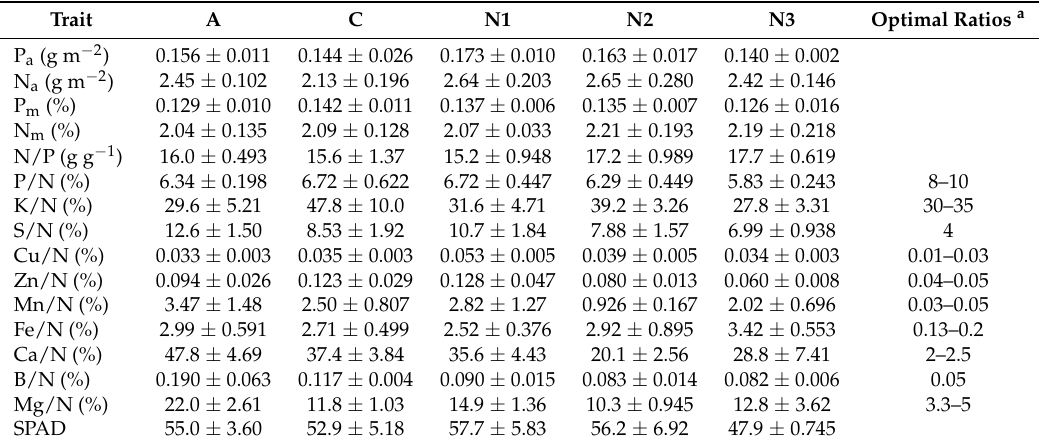
Table 2. Chemical leaf traits at all sites (mean ±